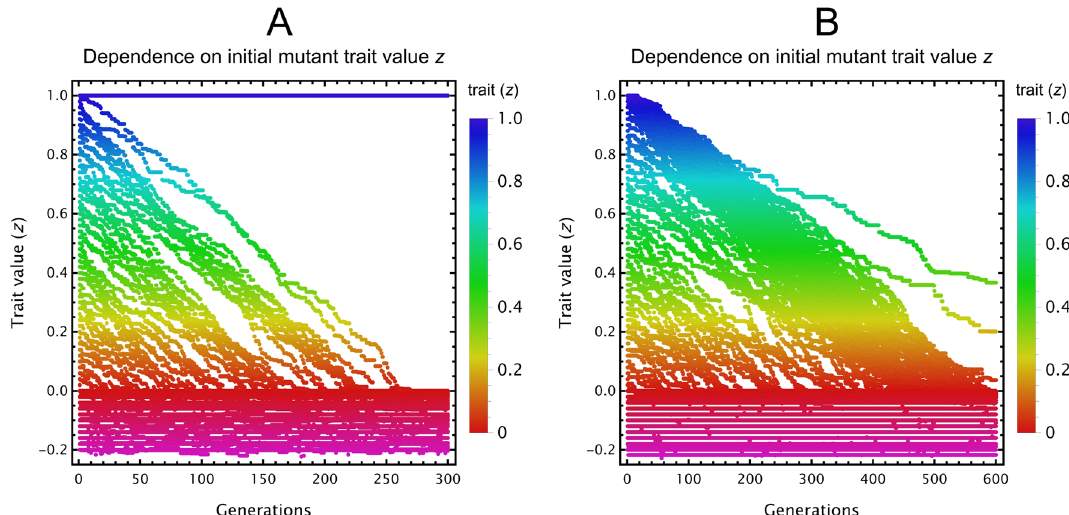
Figure 5. Adaptive dynamics of cross-facilitating species. ( A ) Only species 2 can evolve, species 1 is fixed (blue line at z 1 = 1 ). ( B ) Both species may evolve. In both cases, species evolve toward z ≈ 0 , where mortality is d ≈ 0 and the production rate k of the common good is also ≈ 0 . Parameters: t inv = 5 • 10 5 , n inv = 10 − 2 , µ SD = 10 − 2 , n θ = 10 − 2 , G = 600, z 1 = 1, b 1 = 1, b 2 = 0.1, c 1 = 1, c 2 = 0.1, r 1 = r 2 = 1, δ 1 = δ 2 = 0.1, m 1 = m 2 = 1, s 11 = s 12 = s 21 = s 22 = 0.1,z = 0.5, σ = 0.2, η = 0.1 } . Species at (cid:31)